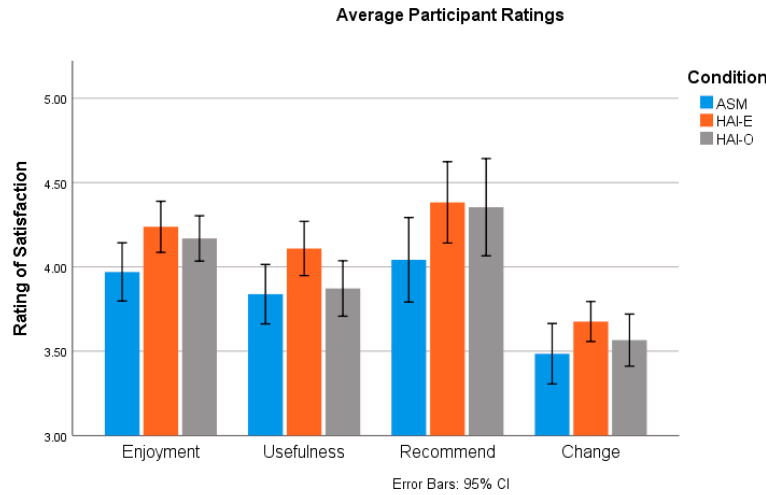
Figure 1. Ratings of responsiveness by condition.